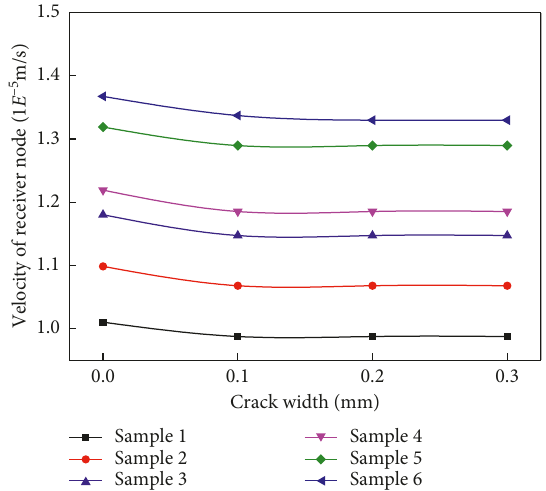
Figure 22: Velocity of receiver node versus crack width.